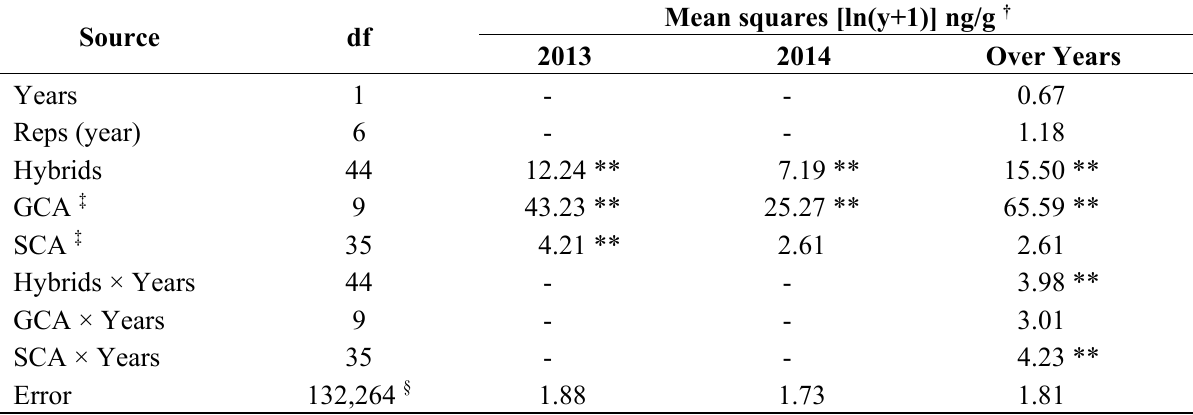
Table 3. Analysis of variance for aflatoxin concentration in grain harvested from a diallel cross grown in 2013 and 2014 at Mississippi State.